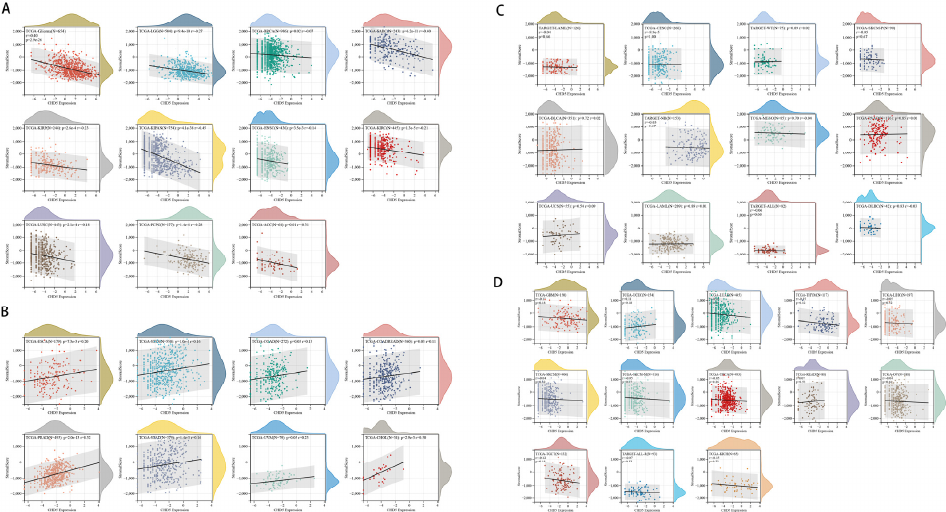
Figure A4. Correlation between CHD5 expression and pan ‐ cancer stromal score. ( A ) CHD5 expression was negatively correlated with stroma scores for KIPAN, SARC, Glioma, ACC, PCPG, LGG, KIRP, KIRC, LUSC, HNSC, and BRCA. ( B ) The expression of CHD5 was significantly positively correlated with the stromal scores of COADREAD, STES, STAD, ESCA, UVM, PRAD and CHOL. ( C , D ) No significant differences were found in other cancers.